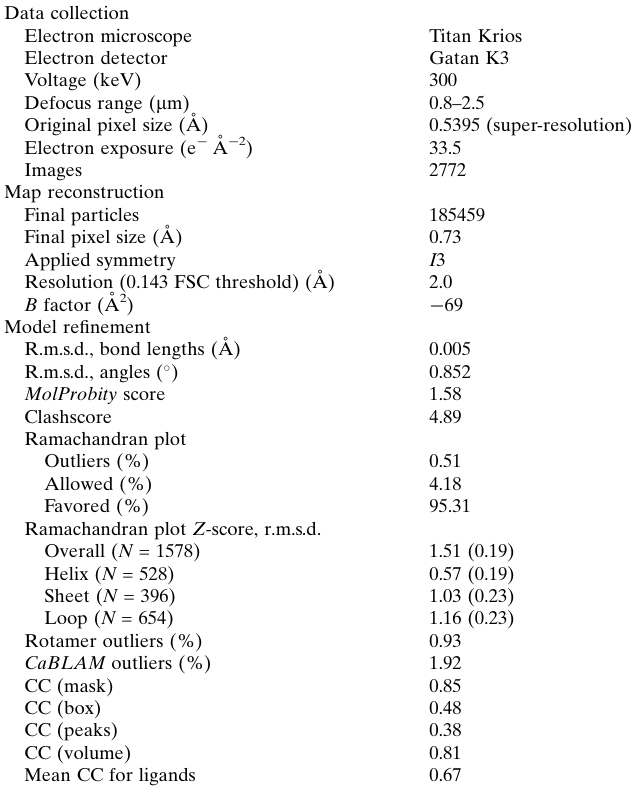
Table 1 Data-collection, map-reconstruction and model-refinement statistics. Data collection Electron